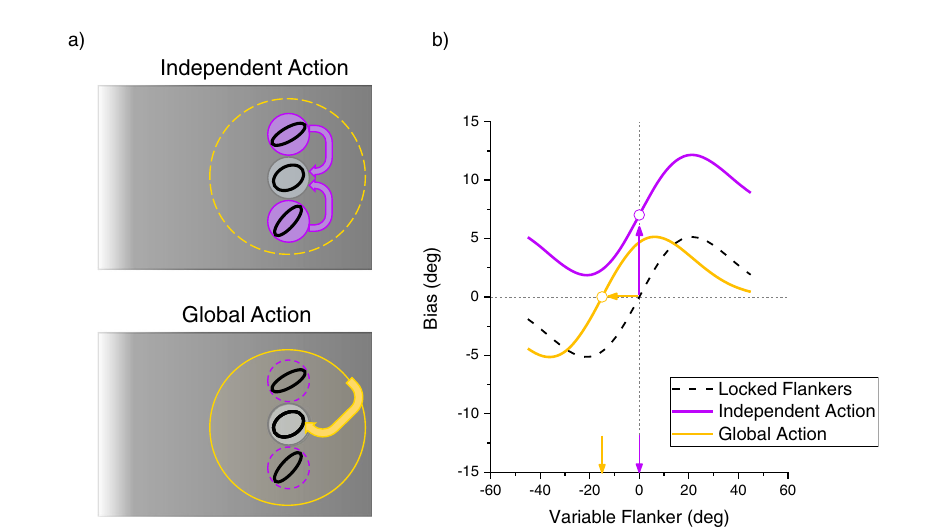
Fig. 4 | Two possible sites of integration and their experimental predictions. a Rationale for investigating the site ofactionofthe fl ankers.They couldeitheract independently on the target (illustrated by purple arrows in top left panel), or fi rst pooled within a larger RF, which in turn biases the target (illustrated by the large yellowcircleandarrowinbottomleftpanel). b Predictionsforthetwohypotheses. If the fl ankers act independently, when one is locked at +15° and the other free to